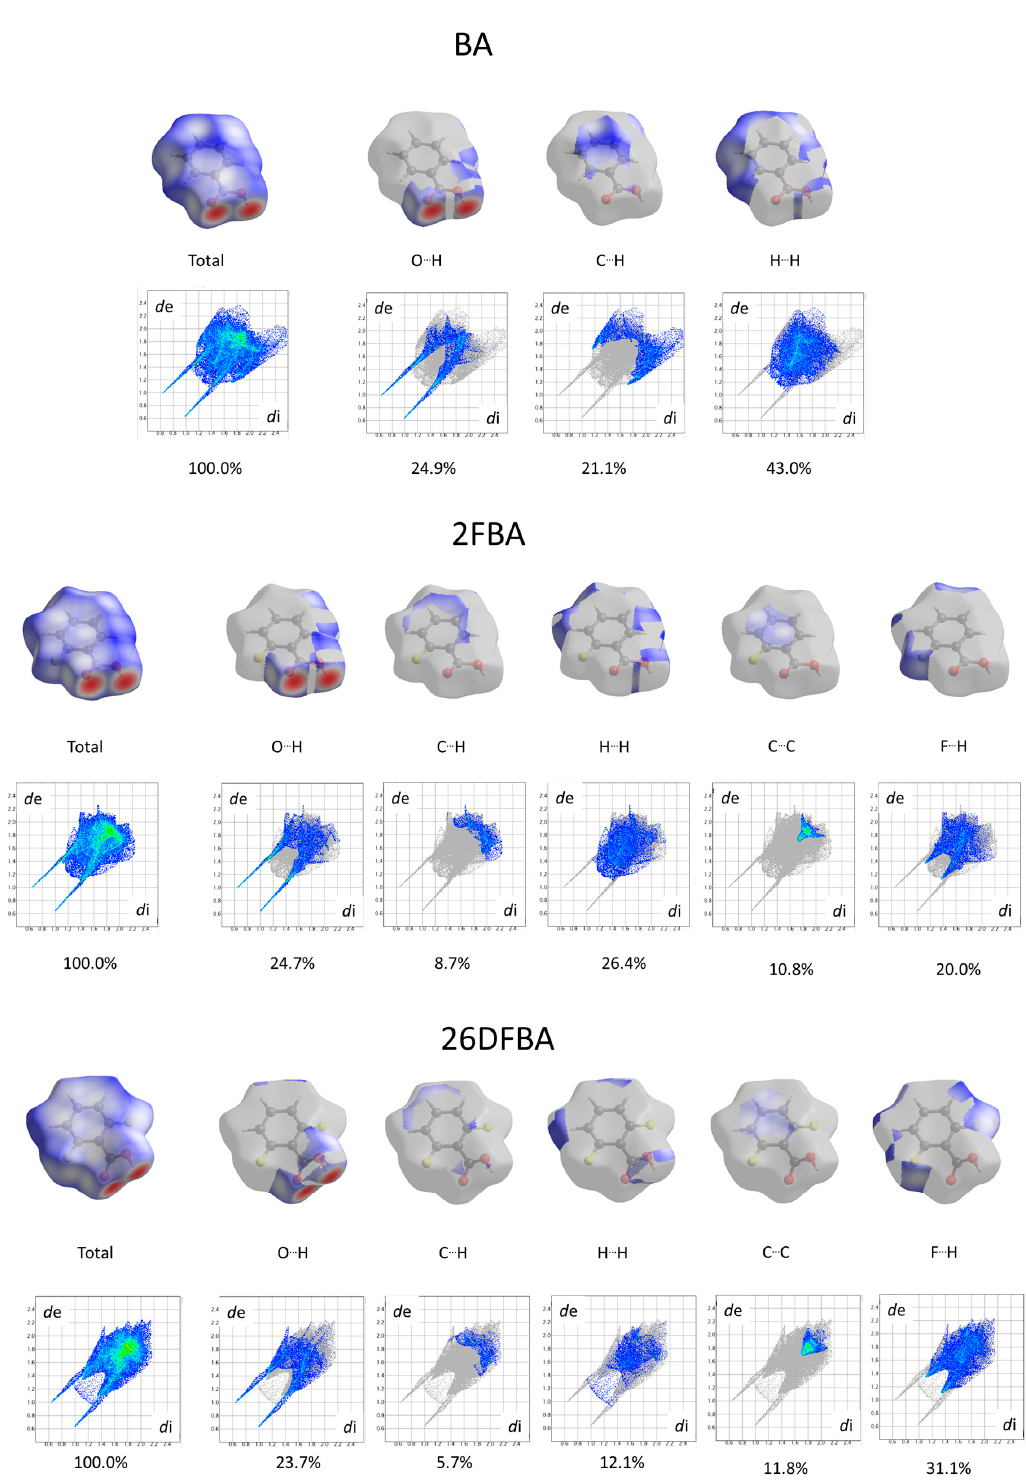
Figure 21. Total and atom ... atom d norm Hirshfeld plots and 2D-fingerprint plots ( d e , d i ) for BA, 2FBA and 26DFBA. Grey, colors means no interaction, blue-to-red colors mean increasing strength of interaction (in the d norm Hirshfeld plots) or increased number of interactions (in the 2D fingerprint plots).